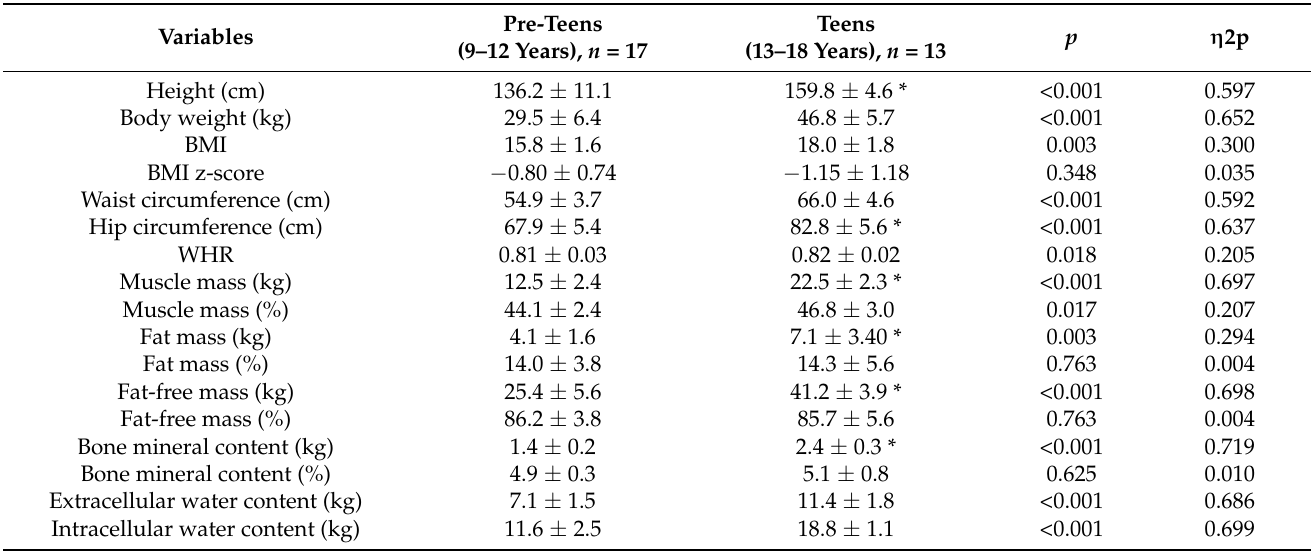
Table 1. General characteristics and body composition by bioimpedance of the